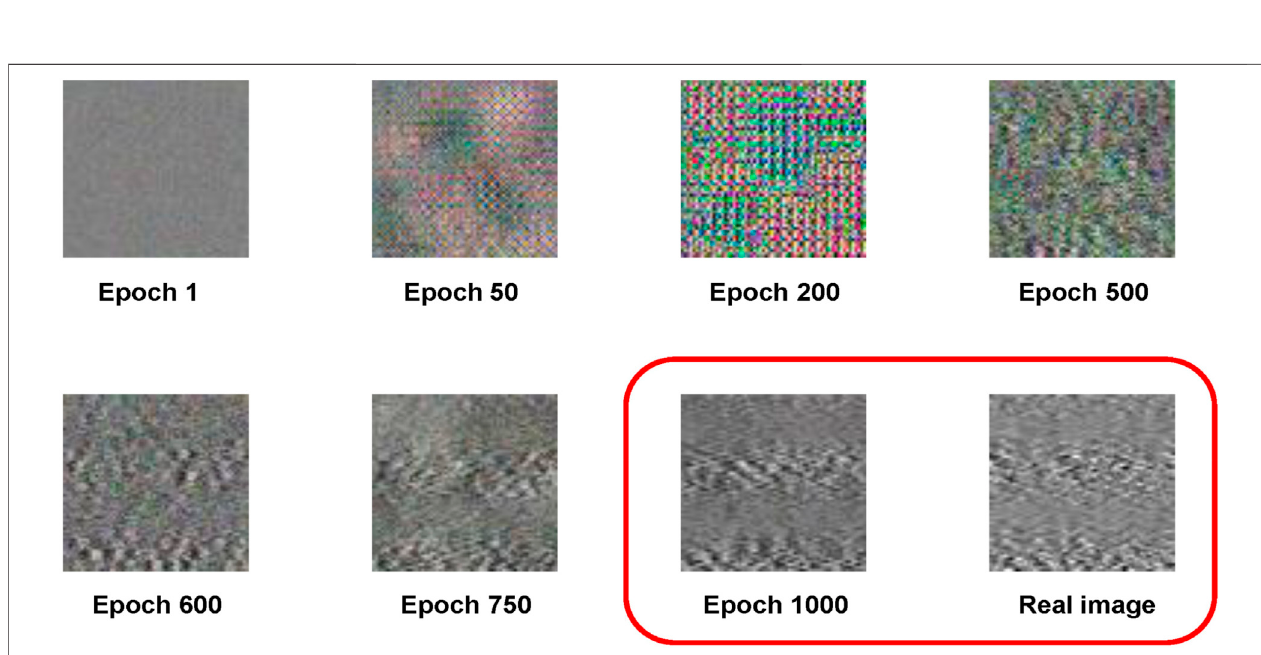
FIGURE 5 | It shows the EMG synthetic images trained by 80 samples at different epochs and compares synthetic images at epoch 1000 with the real image.